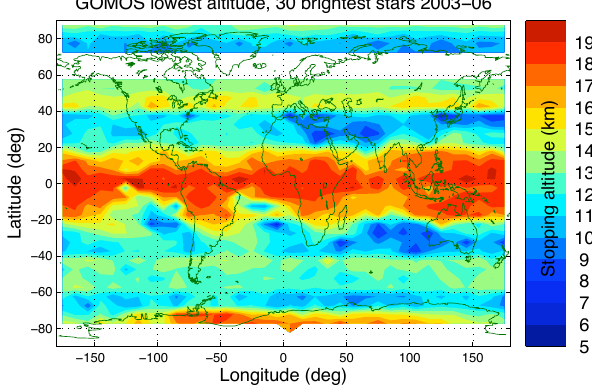
Fig. 6. Distribution of the mean occultation stopping altitude of 30 brightest stars in